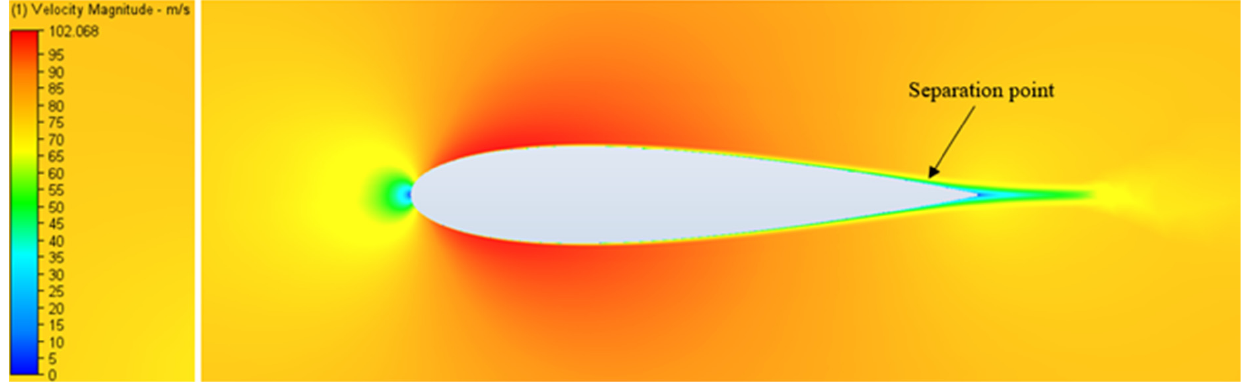
Figure 13. NACA 0017 aerofoil acting at 0° AOA showing Separation point over.